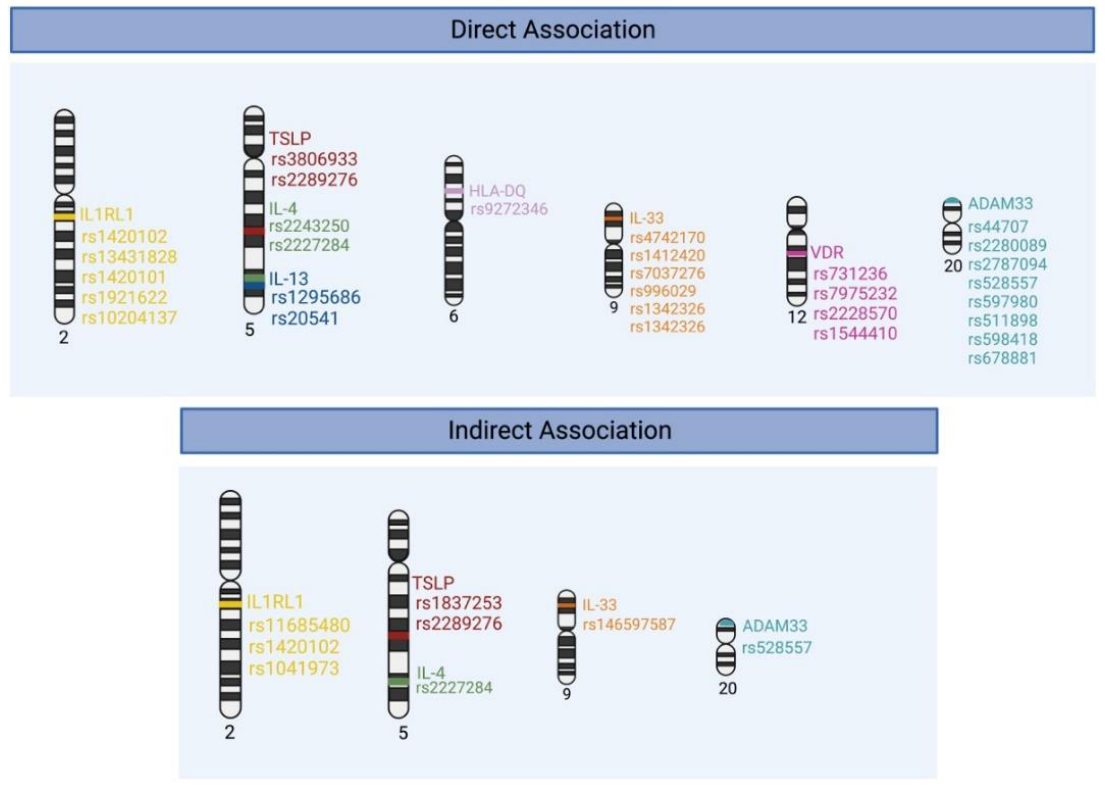
Figure 2. Summary of SNPs associated with asthma. Some SNPs have been reported to have both direct and indirect effects based on the